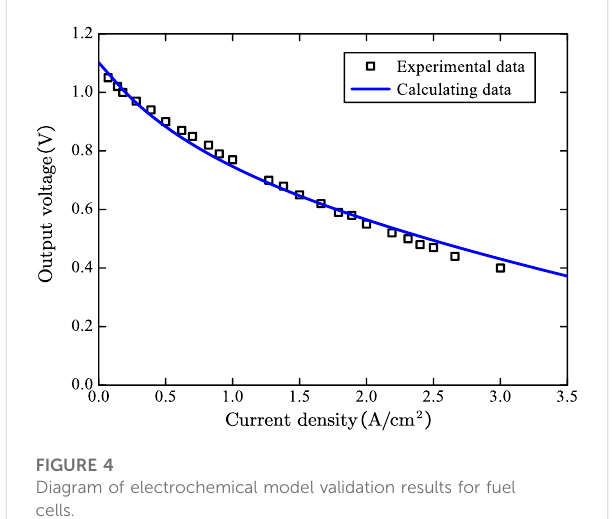
FIGURE 4 Diagram of electrochemical model validation results for fuel